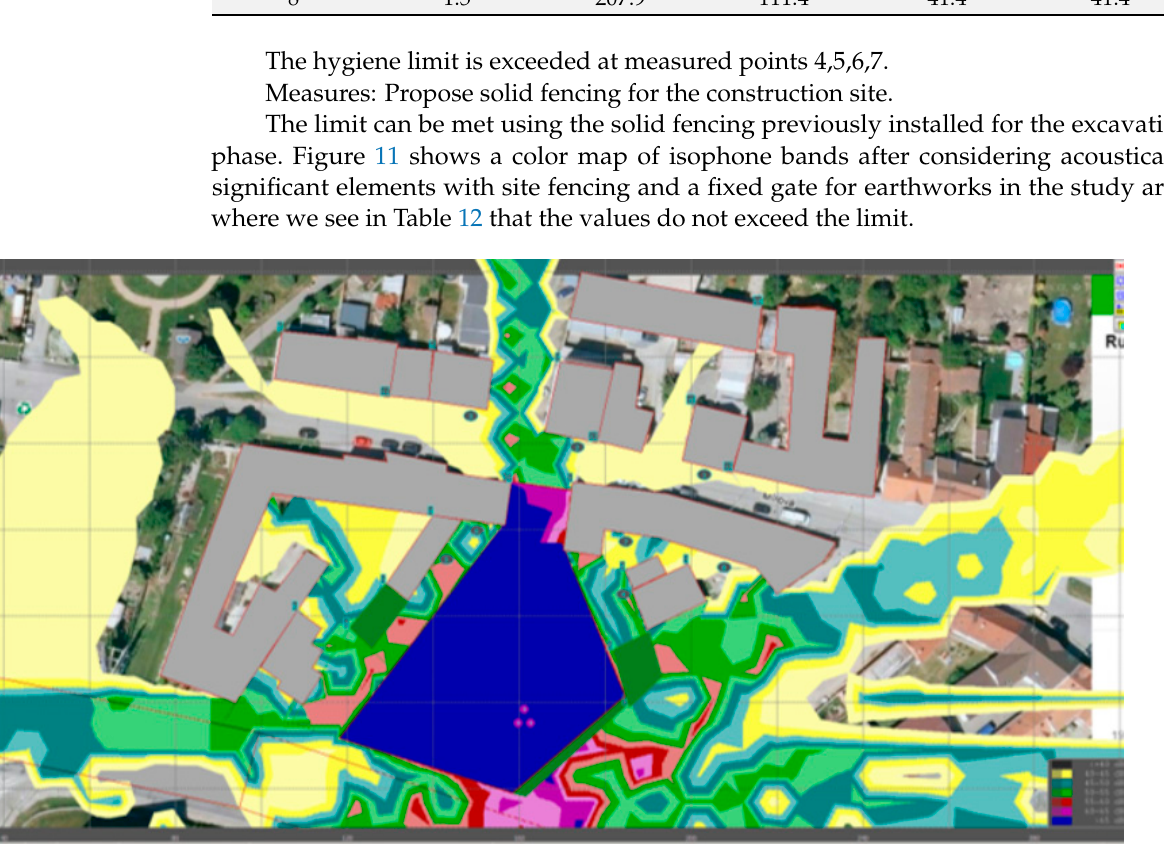
Figure 11. Colour map of isophone bands after the consideration of acoustically significant elements with construction site fencing and a solid gate for earthworks in the investigated area. Table 12. Table of calculated values of measured points for earthworks with construction site fencing and a solid gate in the investigated area.